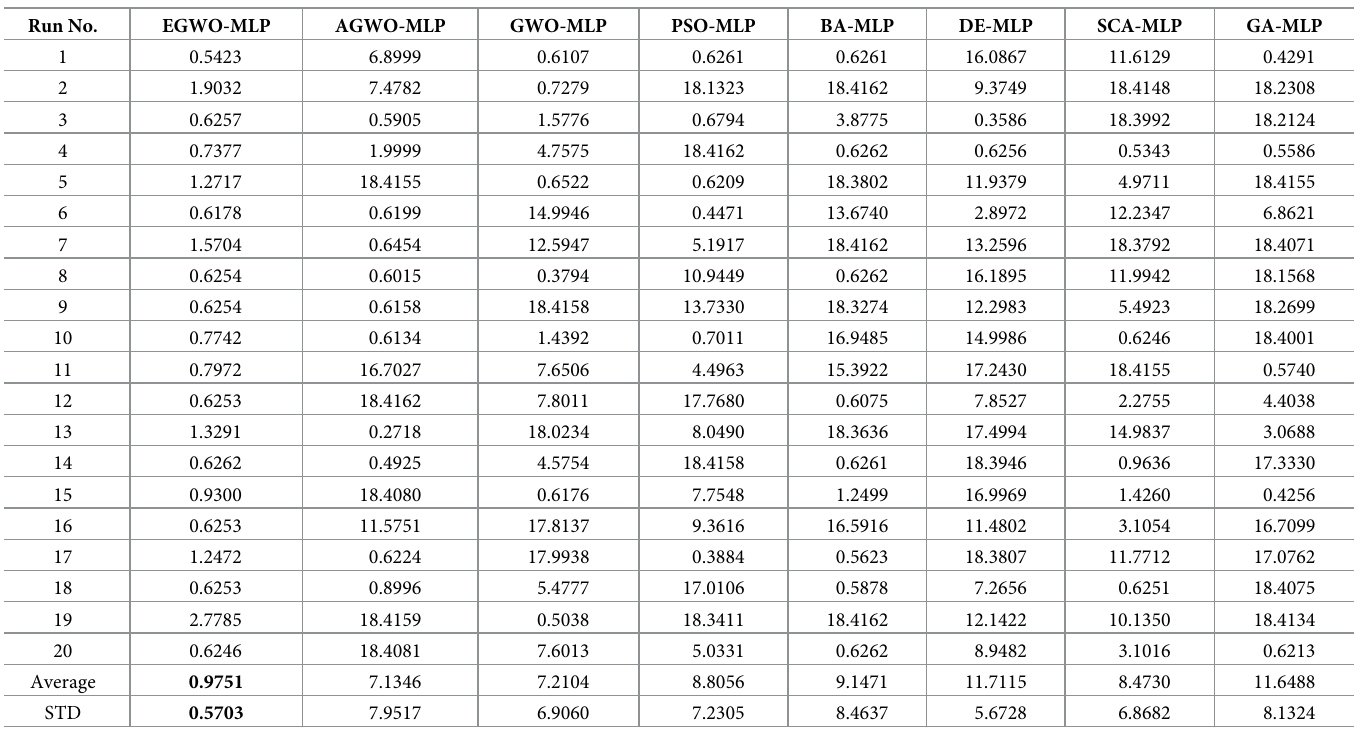
Table 7. The test error for the Portuguese (Por.) subject achievement prediction. Run No.